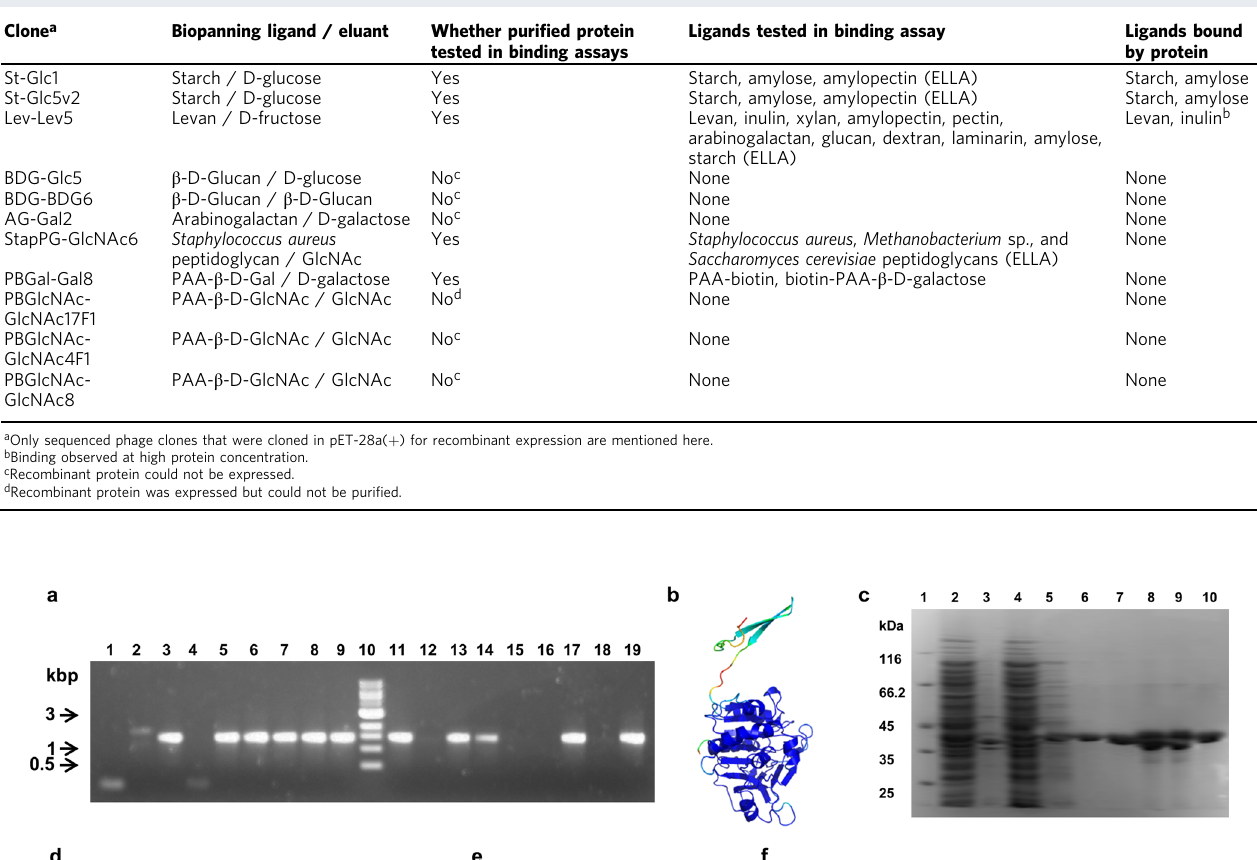
Table 2 Ligand binding pro fi le of clones identi fi ed by biopanning against various plant and bacterial polysaccharides.